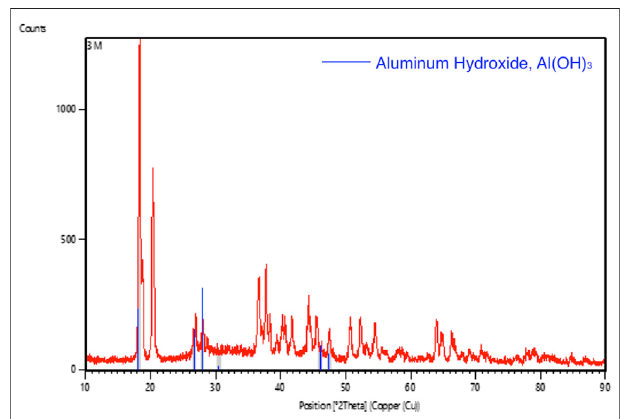
FIGURE 12 | Graphic comparing the XRD pattern (red line) of aluminum foil after tested with 3 M of KOH solution with the standard aluminum hydroxide XRD pattern (blue